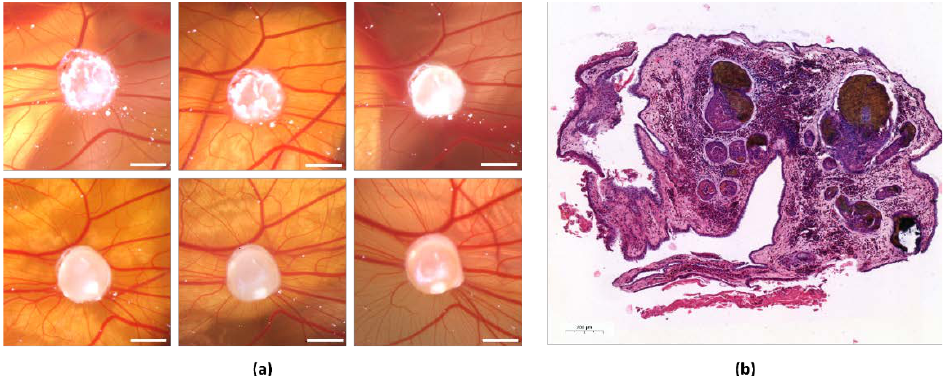
Figure 1. Growth of AS-M cell line tumors on the CAM and H&E staining. ( a ) Series of photographs of angiosarcoma cell line tumors on the CAM from the top left to the bottom right showcasing each day from the 11th until the 16th day of incubation. The white bar indicates 2 mm. ( b ) H&E staining of an AS-M cell line tumor after removal from the CAM after one week.